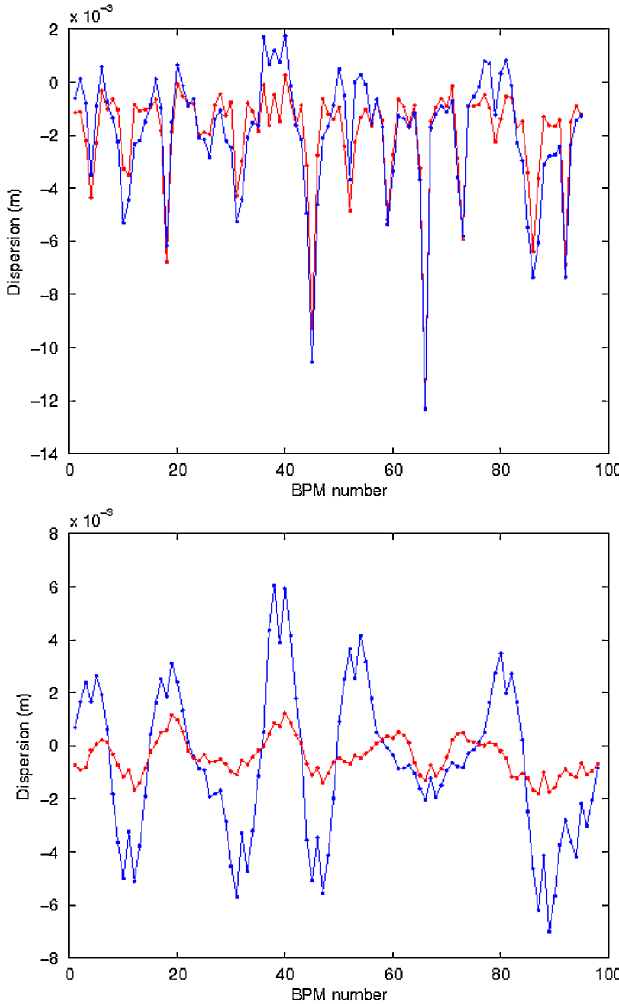
FIG. 6. Dispersion measurement of uncorrected lattice (blue) and dispersion minimized lattice (red). The top plot shows the raw dispersion data, while the bottom plot has the BPM coupling effect removed. Both show a clear reduction in vertical dispersion.